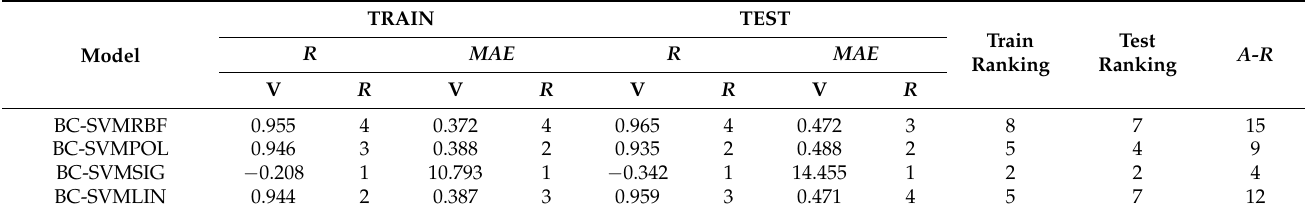
Table 3. Performance results and ranking values of different ML approaches applied in this study.